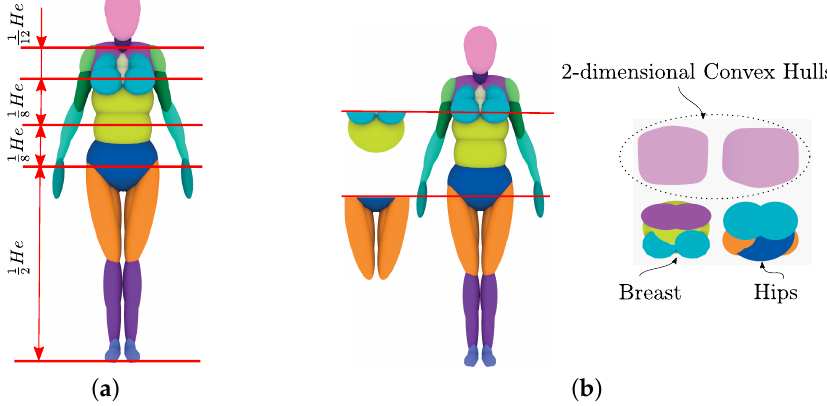
Figure 15. Tailor measuring of ellipsoid mannequins with heights at which m T () is applied and example of cross sections obtained and measured with m T () of breast and hips of Small Slim ellipsoid model. ( a ) Heights at which 2D convex hulls are computed. ( b ) Examples of 2D convex